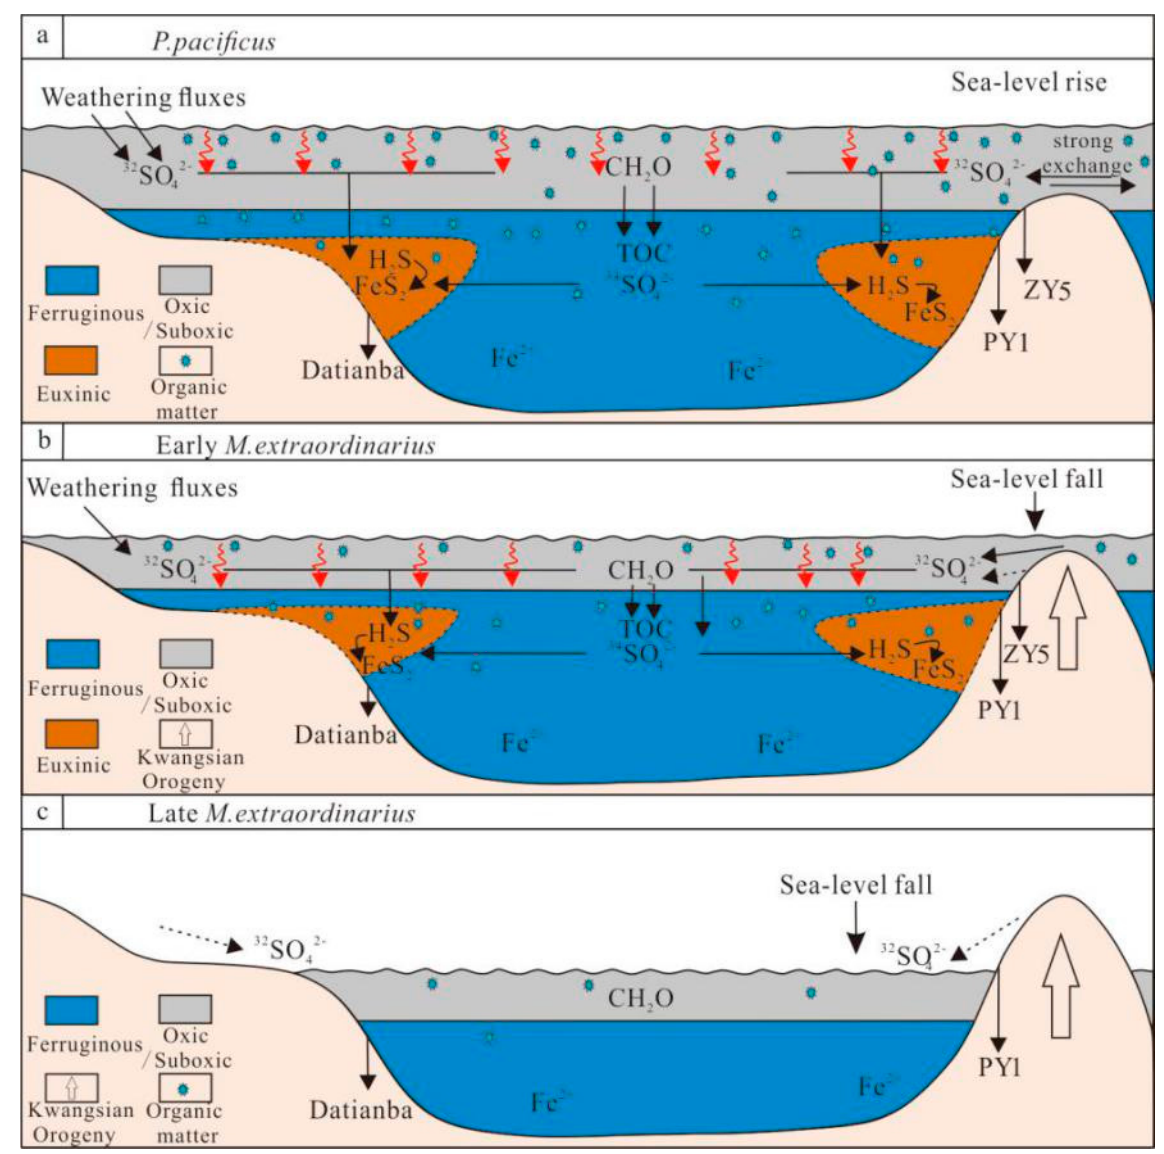
Figure 9. Schematic of a stratified redox model for the Late Ordovician inner Yangtze Sea. ( a ) oceanic redox structure in the P. pacificus zone; ( b ) oceanic redox structure in early the M.extraordinarius zone, ( c ) oceanic redox structure during the late M.extraordinarius zone. The sedimentary model is based on geochemical data from the Datianba section and Well PY1 [8,10].